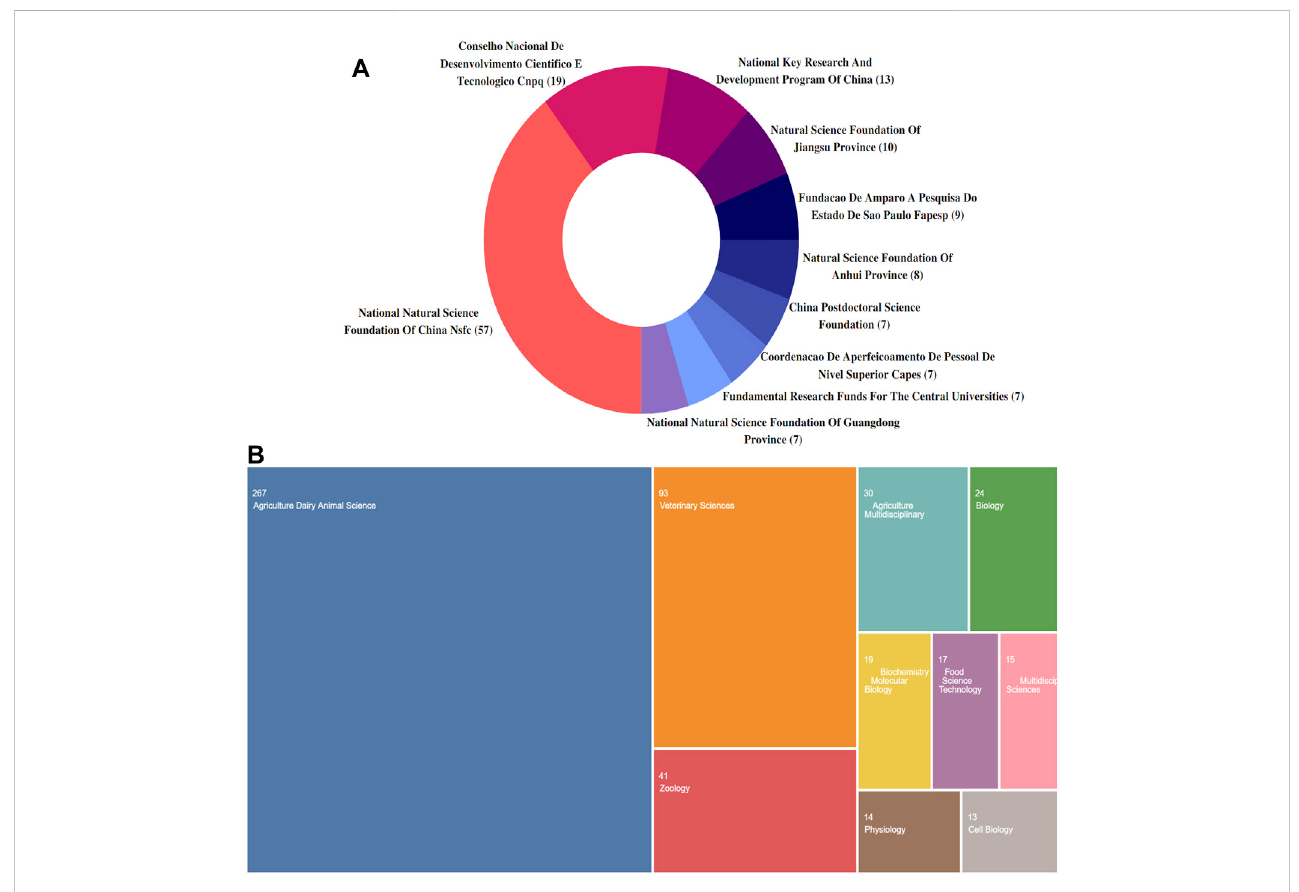
FIGURE 3 Overview of global research on heat stress in poultry. (A) Contribution of various funding bodies. (B) Research areas according to subject